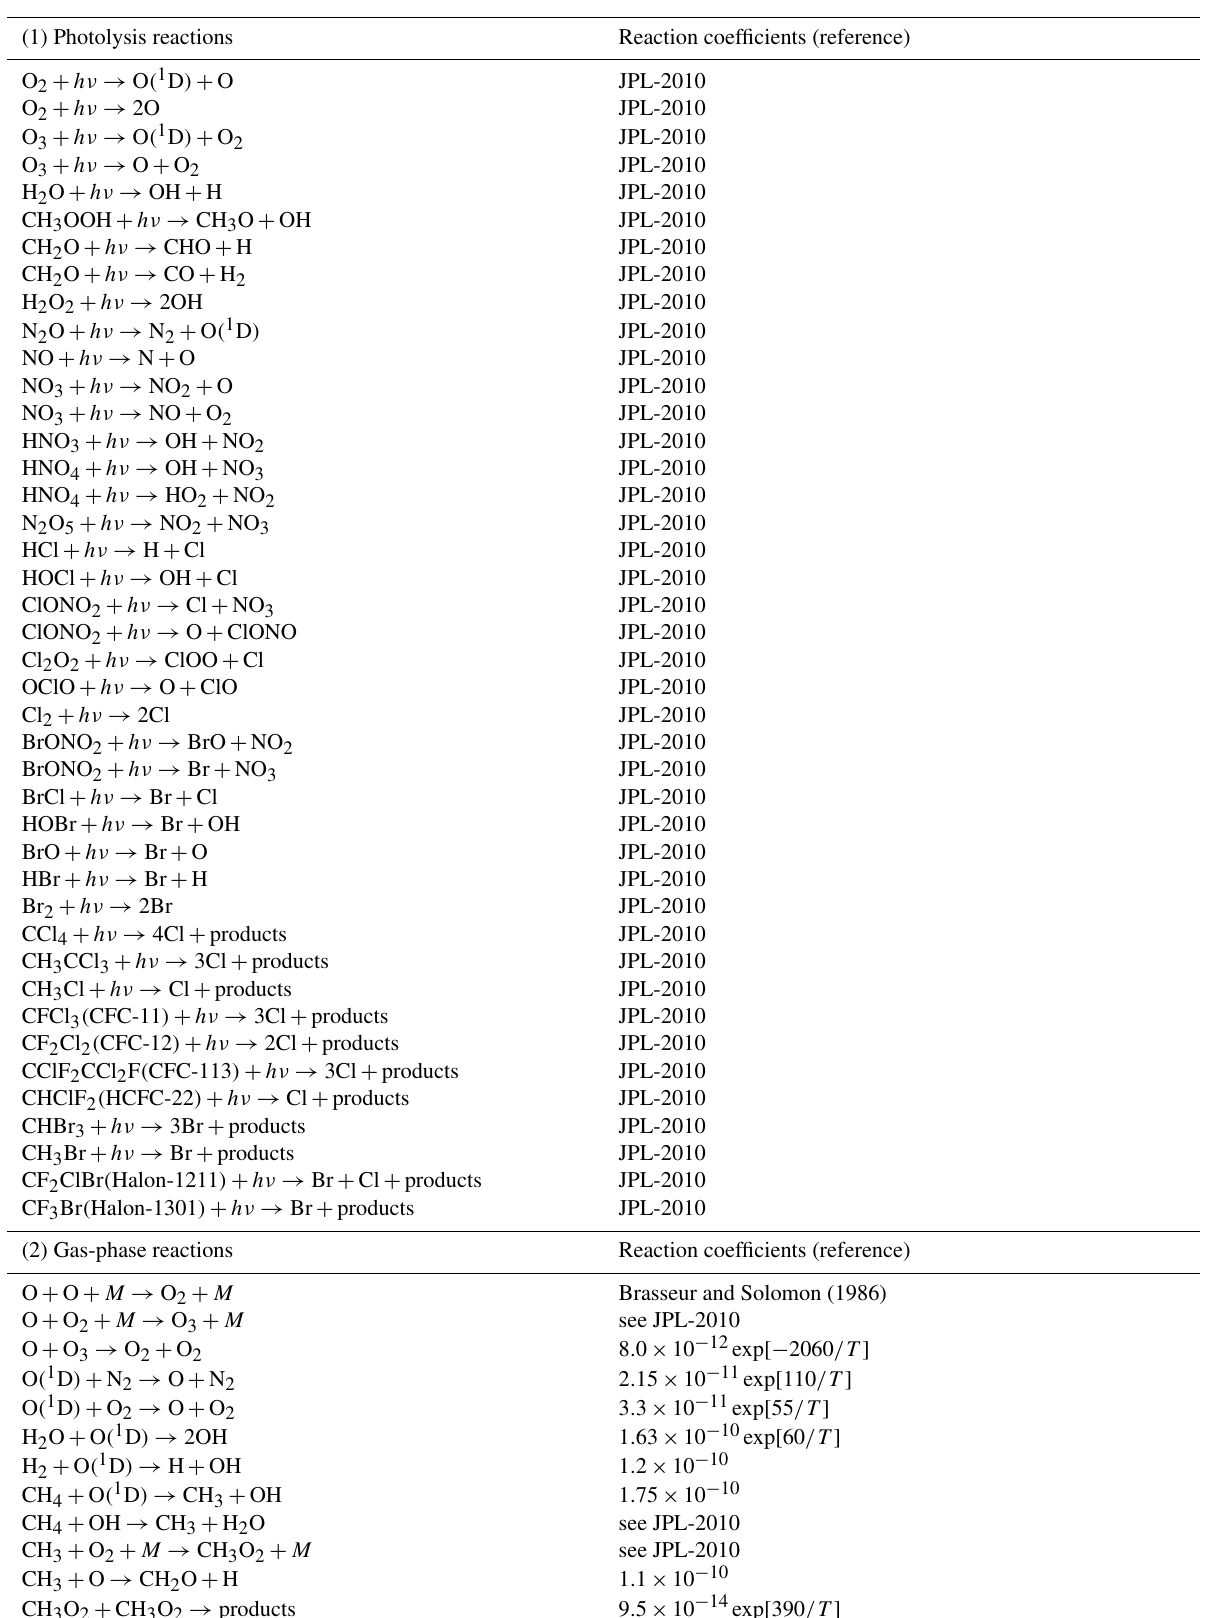
Table A2. Chemical reactions in the MIROC3.2 chemistry–climate model. (1) Photolysis